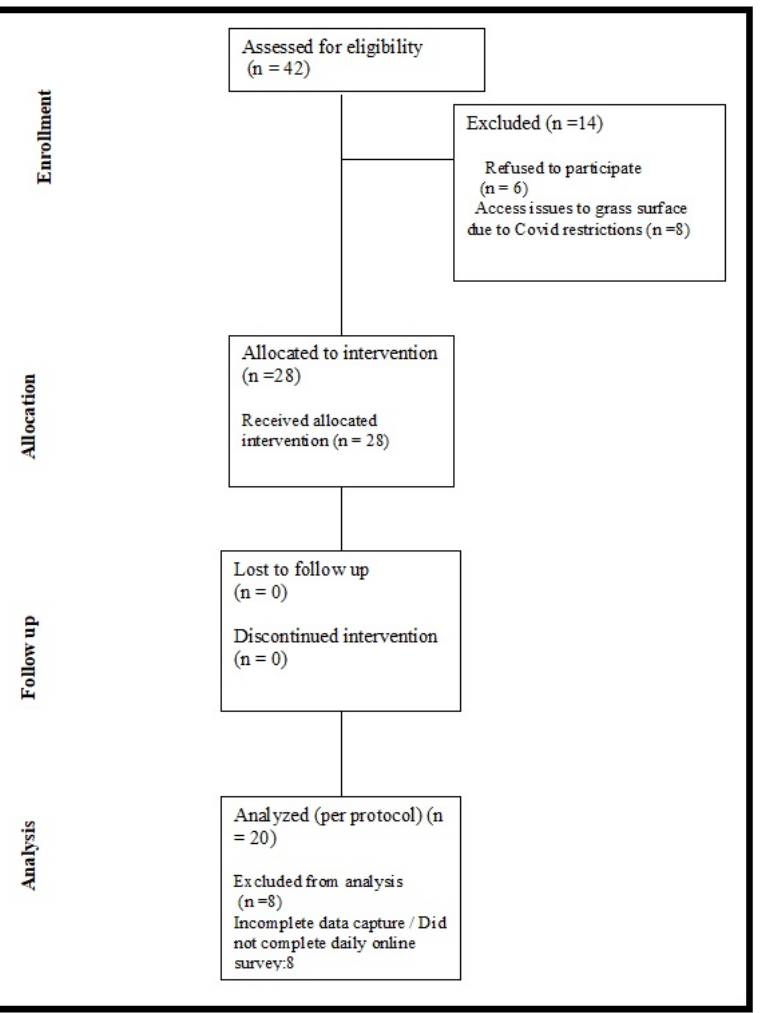
Figure 1. Participant recruitment and participation flow chart.